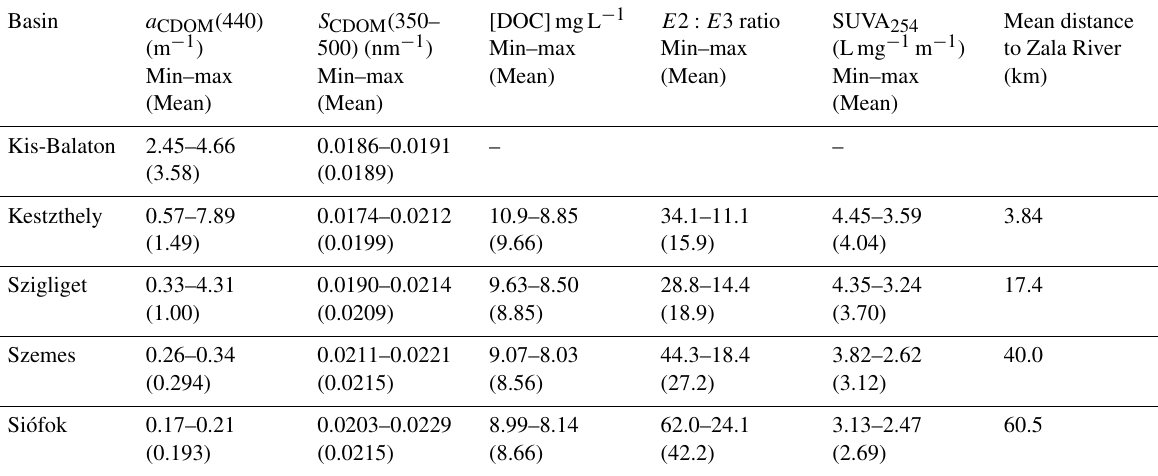
Table 3. Values of CDOM absorption coefficient at 440nm, CDOM slope coefficient between 350 and 500nm, DOC concentration, E 2 : E 3 ratio, SUVA254 and mean distance of the basin to Zala River. Values obtained for CDOM spatial variation (values July 2014). Basin